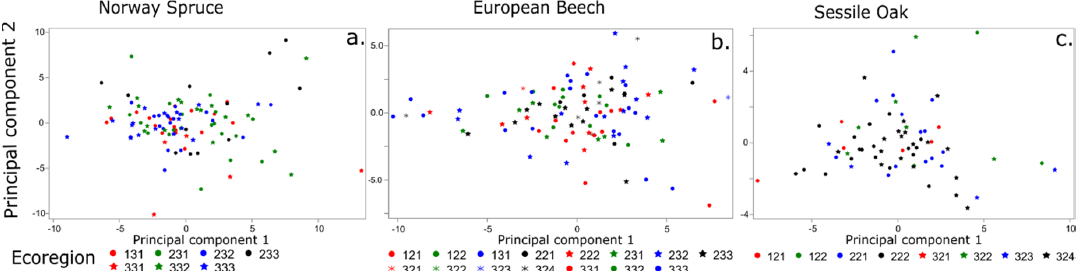
Figure 5. Grouping by ecoregions for Norway spruce ( a ), European beech ( b ), and Sessile oak ( c ) with principal components 1 and 2 as axes. Because similar results were obtained for DBHi and BAi, we have represented only the results for DBHi.